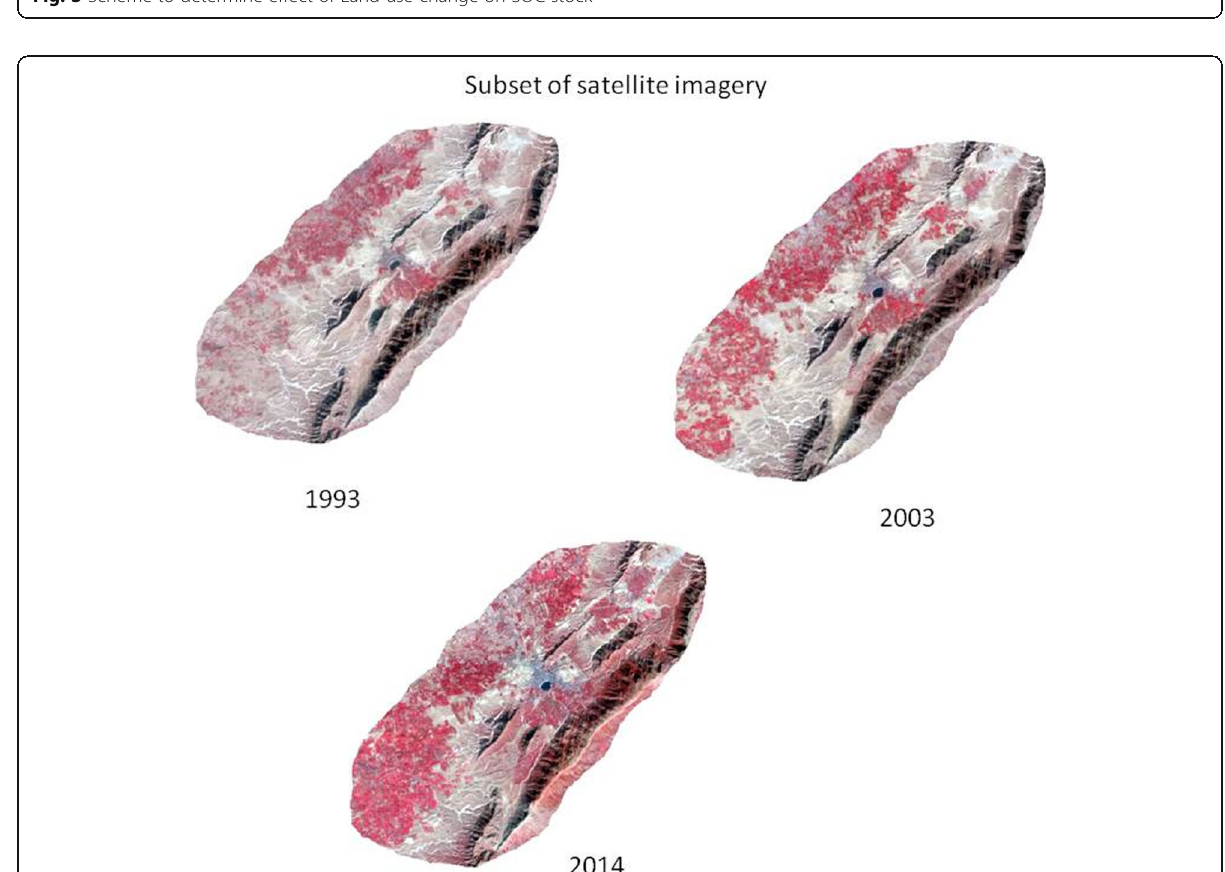
Fig. 4 Subset of multispectral satellite imageries (1993 –